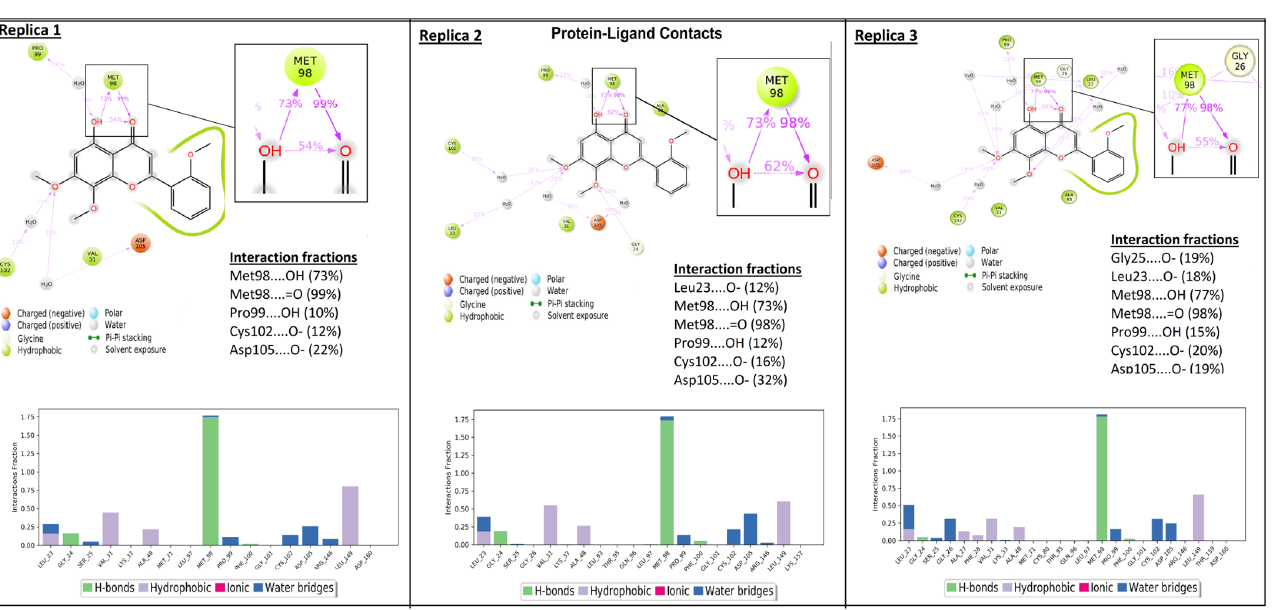
Figure 7. EGFR–Andrographin complex 100 ns MD production run. ( A ) Protein RMSF plot. ( B ) A gyration plot depicting the extendedness of a ligand. ( C ) A gyration plot of protein during a 100 ns production run.